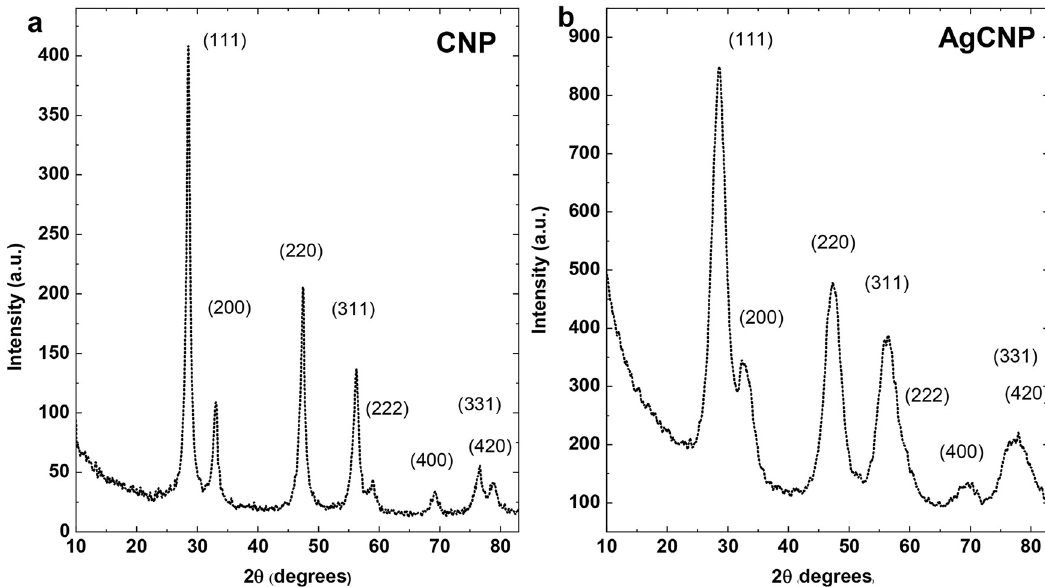
Fig 4. X-ray Diffraction (XRD) measurement via CuK α irradiation. ( a ) CNP and ( b ) AgCNP; peak indices are common to cerium oxide fluorite structure ( Fm �3 � m space group). Peaks in ( b ) show substantially increased broadening relative to those in ( a ) (0.668 to 3.342 FWHM at (111)) highlighting a potential decrease in crystallite diameter due to susceptibility to chemical treatment. All peaks match with ceria (CeO 2 ) reference pattern, ICSD:186923, ICDD:98-018-6923.